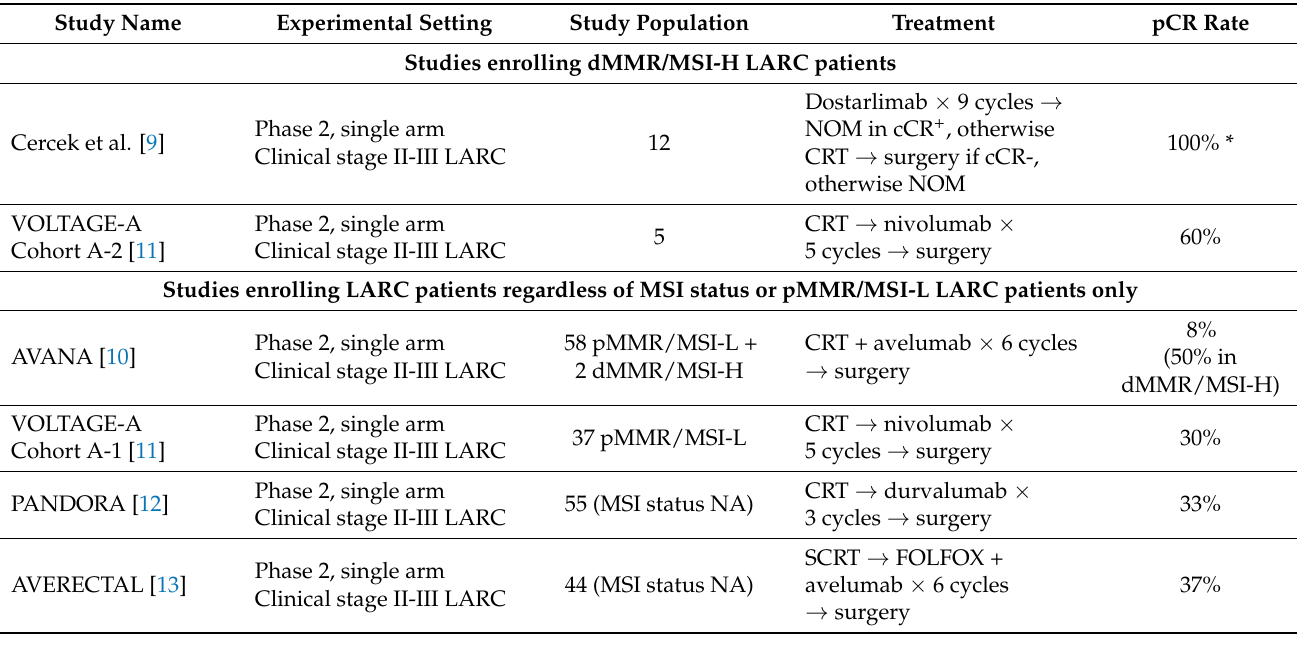
Table 1. Studies incorporating immunotherapy in LARC